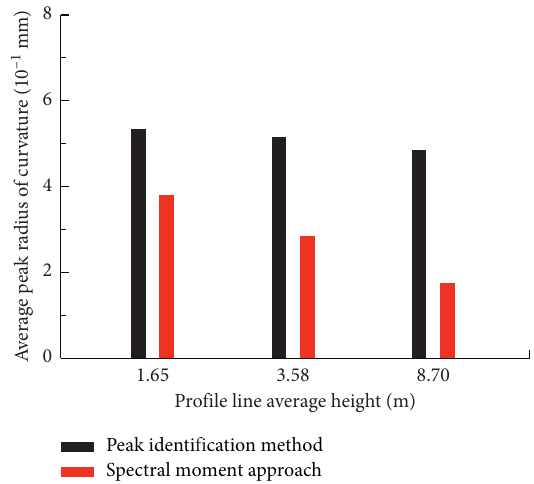
(m)1.65 3.58 Profile line average height